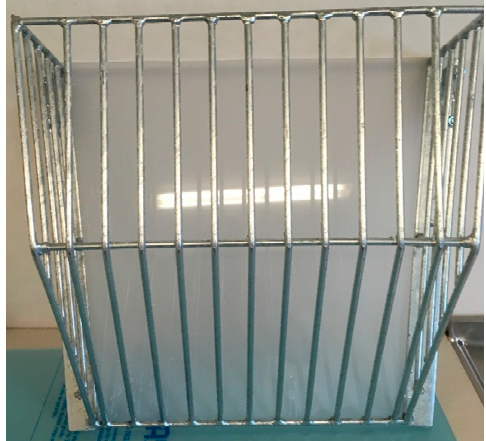
Figure 2. Modified straw rack from JYDEN (3620-2012). The modification consisted of a plastic back-plate. The rack was fitted on the pen wall with pipe clamps. (Table 1). If the straw rack was full, no new straw was provided. Table 1. Scoring system used to assess leftover straw on the floor and in straw racks (modified from Pedersen et al., 2014 [19]).